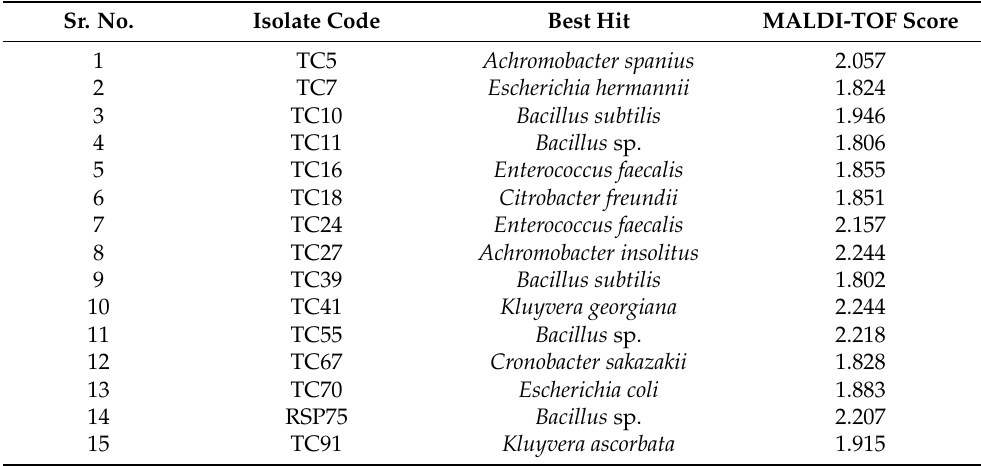
Table 1. MALDI-TOF mass spectrometry-based biotyping of bacteria isolated from the gut system of the red flour beetle, T. castaneum . Sr.